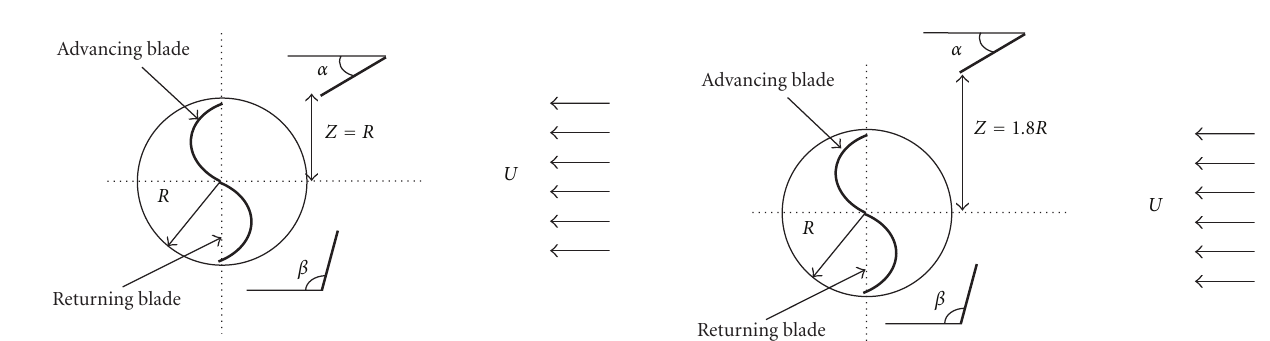
Figure 8: Schematic of modified Savonius rotor with space para- meters of two deflector plate ( Z = 1 . 8 R